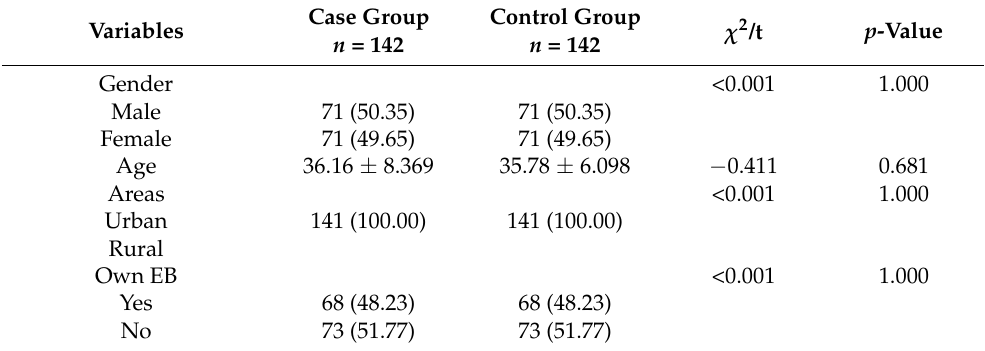
Table 1. Comparison of baseline conditions between the case group and the control group, n